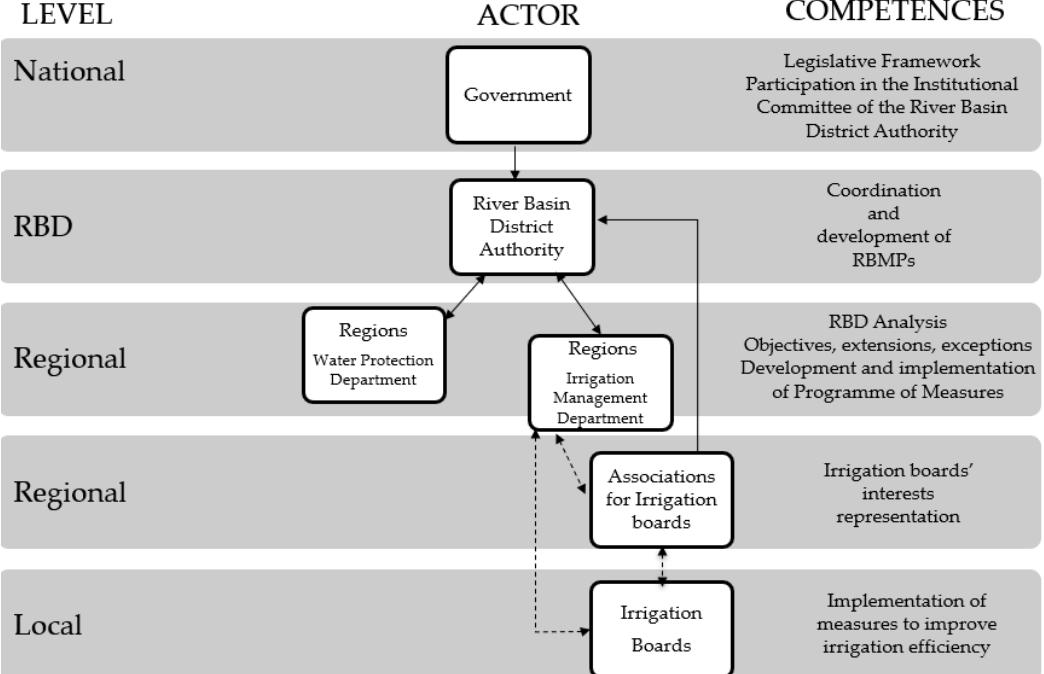
Figure 3. Main actors, relations and competences for the implementation of measures to improve irrigation efficiency under the WFD in the Eastern Alps RBD. Arrow means formal relations defined by the Legislative Decree 152/2006; dashed arrow means informal relations. Source: Authors’ own elaboration.